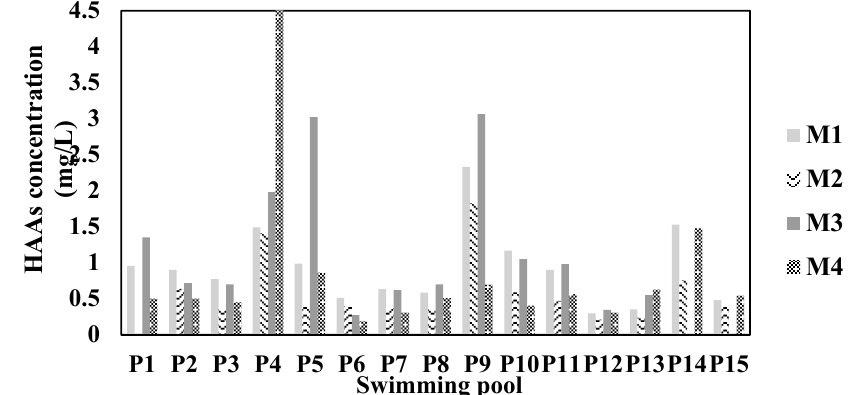
Figure 2. Concentration of HAAs in the public pools selected for the study.